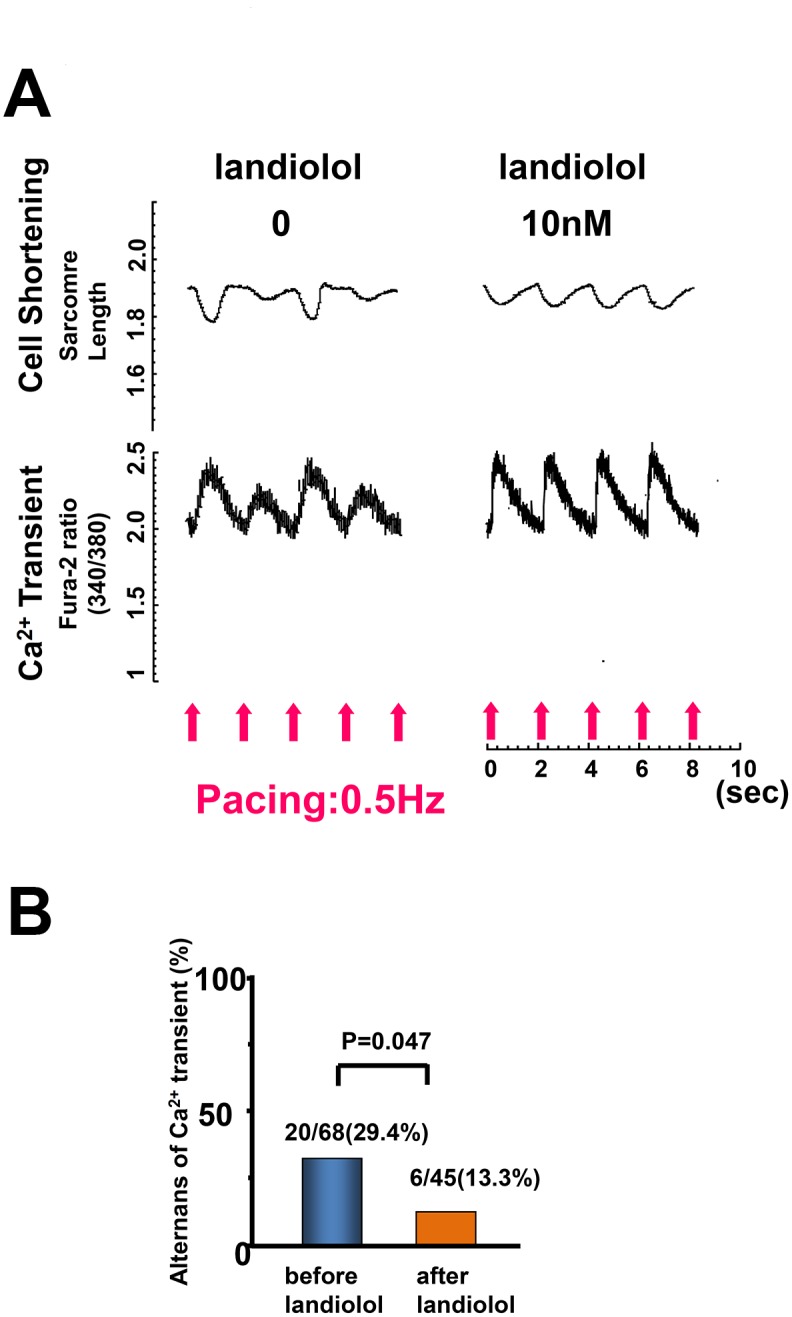
Alternans of cell shortening and Ca2+ transient in failing cardiomyocytes and its recovery by low-dose landiolol.A. Representative data. B. A bar graph representation of the data in Fig. 4A.